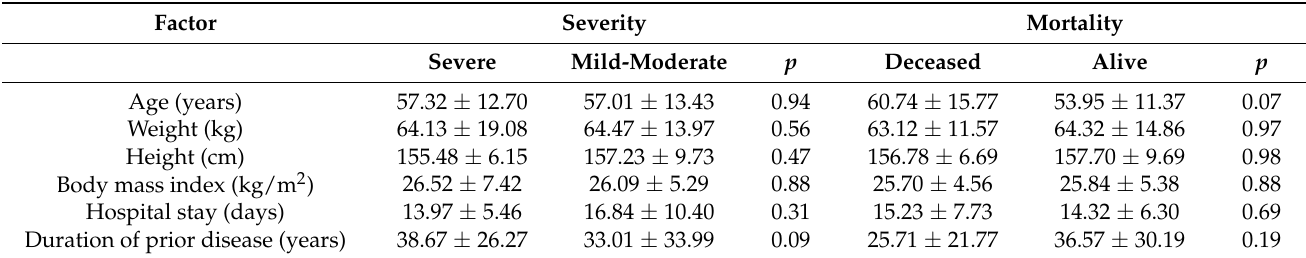
Table 1. Descriptive analysis of the cohort.